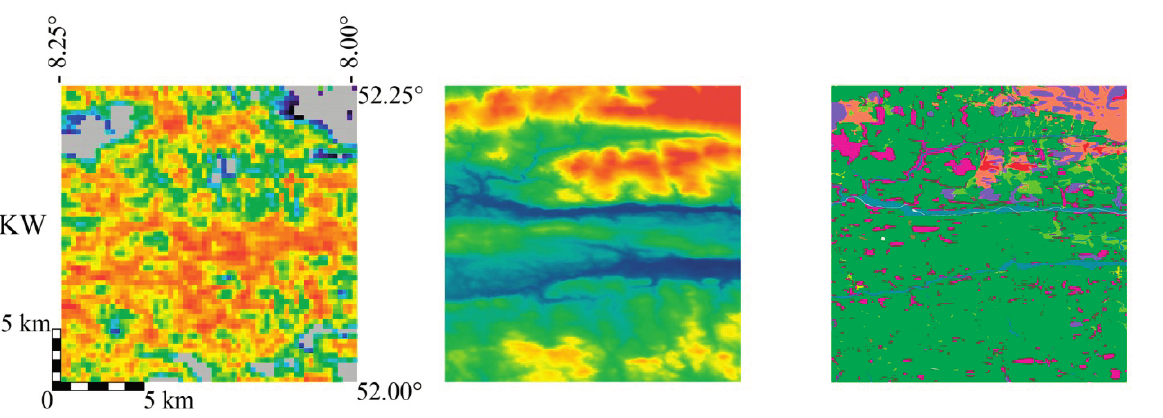
Figure 6. ( Left ) ASAR SM vs. ECV SM correlation maps evaluated for each ASAR pixel. ( Middle ) DEM maps. ( Right ) Soil